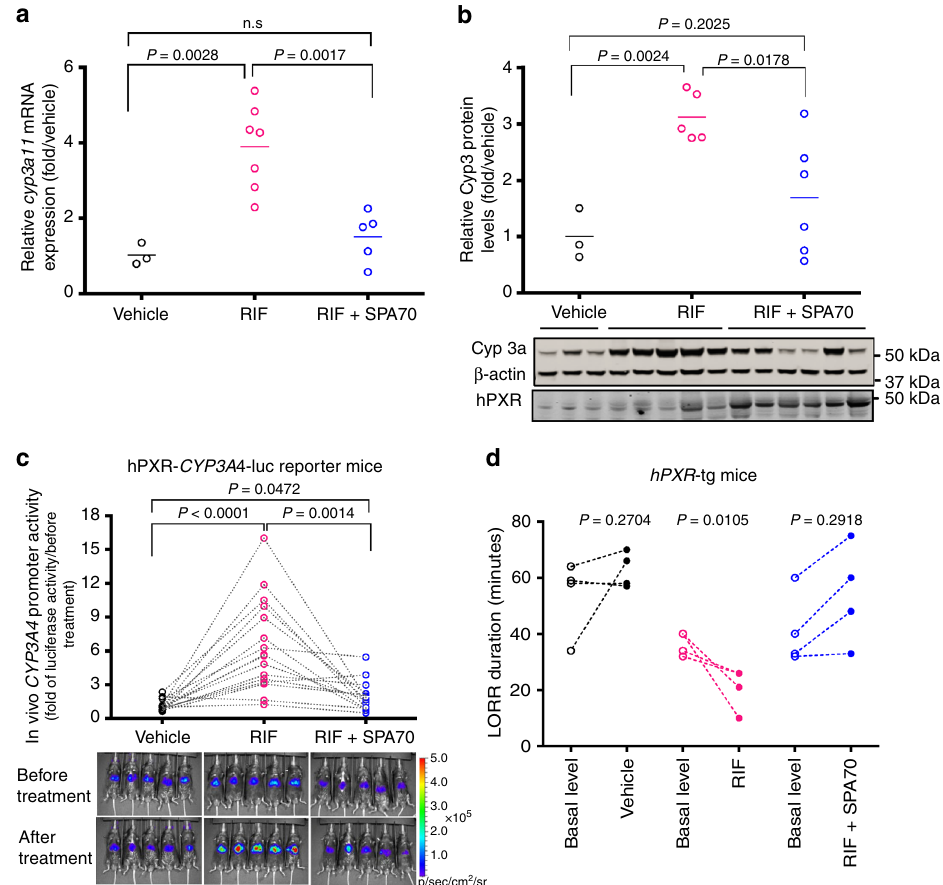
Fig. 4 SPA70 antagonizes hPXR-mediated drug metabolism in humanized PXR mouse models. a Liver Cyp3a11 mRNA was analyzed by real-time PCR in hPXR transgenic (hPXR-tg) mice treated for 72 h with vehicle control (Vehicle), rifampicin (RIF) (10 mg kg − 1 ), or RIF (10 mg kg − 1 ) plus SPA70 (200 mg kg − 1 ). b Liver CYP3A protein levels in the hPXR-tg mice described in a were determined by western blotting. Each data point represents the level of Cyp3a11 mRNA a or protein b from an individual mouse; the short horizontal lines indicate the mean value for three to seven mice from the experimental group. Representative western blots from each group are shown in the lower panel of b . c The hPXR-CYP3A4-luc reporter mice ( n = 15) were generated by hydrodynamic injection of the pGL3- CYP3A4-luc reporter and pcDNA3- hPXR . Each mouse received three rounds of sequential treatment with vehicle control (Vehicle), RIF (10 mg kg − 1 ) or RIF (10 mg kg − 1 ) plus SPA70 (150 mg kg − 1 ) every 24 h for 2 days, with a washout period of 72 h between each treatment round. The luciferase activity in these mice was recorded by bioluminescence imaging 10 h after the last treatment in each round, and the induction of CYP3A4-luc activity was calculated as described in Methods. Each data point represents the CYP3A4 promoter reporter activity in an individual mouse, and each dotted line indicates the change in luciferase activity between rounds of treatment for the same mouse. The bioluminescence images of luciferase activity from fi ve representative hPXR-CYP3A4-luc reporter mice after each treatment are shown. The rainbow scale represents relative light units (photon fl ux per second per square centimeter), positively re fl ecting the luciferase activity. d Duration of the loss of righting re fl ex (LORR), recorded as described in Methods to measure the metabolism of the anesthetic (2,2,2-tribromoethanolamine) in hPXR-tg mice before (basal level) and after treatment with vehicle, RIF, or RIF plus SPA70. Each data point represents the LORR duration in an individual mouse; the lines indicate the LORR duration change in individual mice before and after treatment. P- values were obtained for the two indicated treatment groups by using a paired t